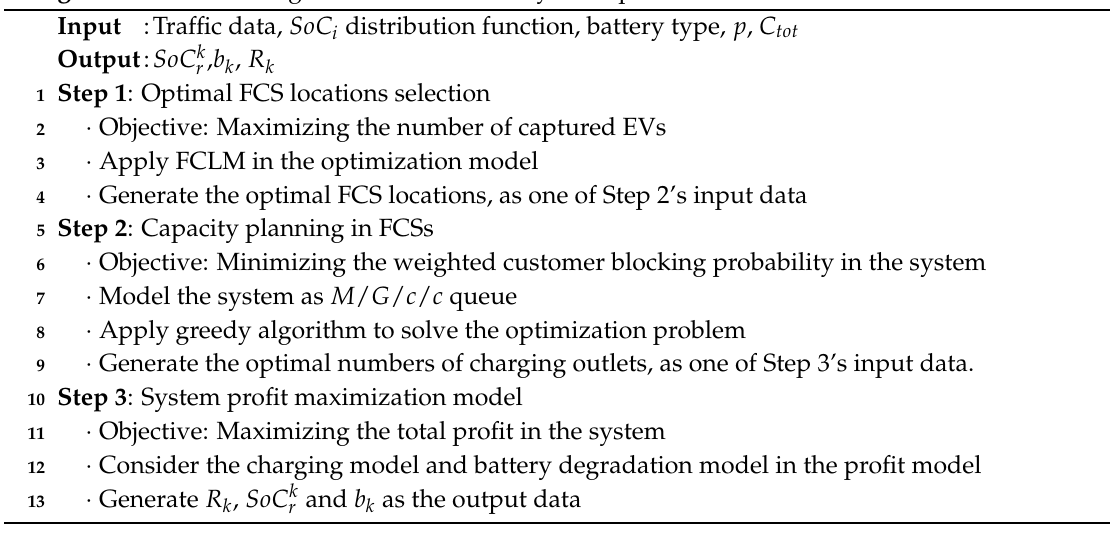
Algorithm 1: Overall algorithm of the three-layered optimization